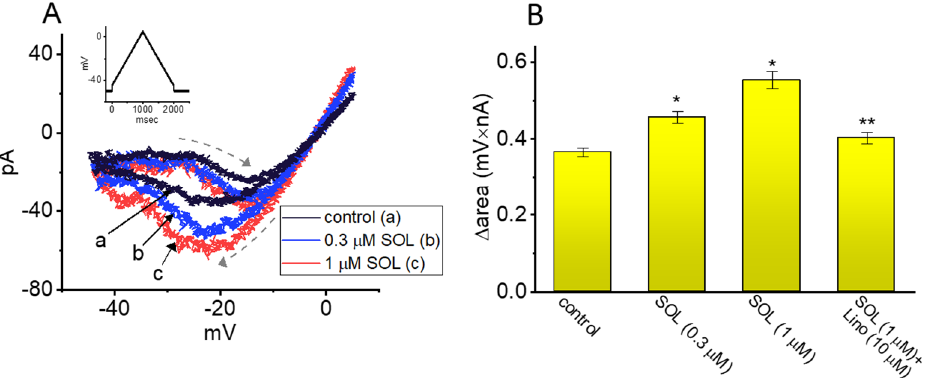
Figure 6. Stimulatory effect of SOL on voltage−dependent hysteresis (V hys ) of I K(M) in GH 3 cells. This set of experiments was conducted with an isosceles−triangular ramp pulse. ( A ) Representative current traces activated in response to isosceles−triangular ramp pulse with a duration of 2 sec obtained in the control period (black line, a) and during cell exposure to 0.3 μM SOL (blue line, b) or 1 μM SOL (red line, c). The dashed arrows indicate the distinctive patterns of current trajectory by which time passes as the ramp pulse is applied. The voltage−clamp ramp pulse is illustrated in inset at the left upper corner. ( B ) Hysteretic area (i.e., Δarea) of I K(M) V hys gained in control period (i.e., SOL was not present) or during exposure to SOL and SOL plus linopirdine (Lino). The area encircled by current amplitudes activated in the ascending and descending limb at the voltages between −45 and 0 mV was calculated. Each bar indicates the mean ± SEM ( n = 7 for each bar). Data analysis was performed by ANOVA−1 ( P < 0.05). * Significantly different from control ( P < 0.05) and ** significantly different from SOL (1 μM) alone group ( P < 0.05).